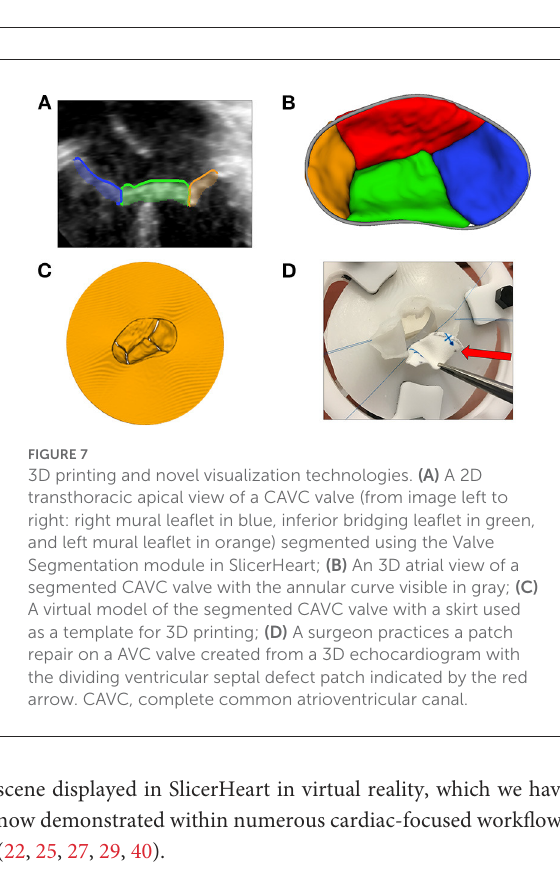
FIGURE5 Comparison of 3D Slicer vs. QLab Mitral Valve Quantification (MVN). (Left) volume rendering of a mitral valve viewed from the left ventricle in Qlab (A) and 3D Slicer (B) ; 2D Transesophageal view of the mitral valve highlighting the AL and PM points in Qlab (A) and 3D Slicer (B) ; 3D Model generated in Qlab (A) and 3D Slicer (B) . Qlab, Philips Medical, Andover, MA.